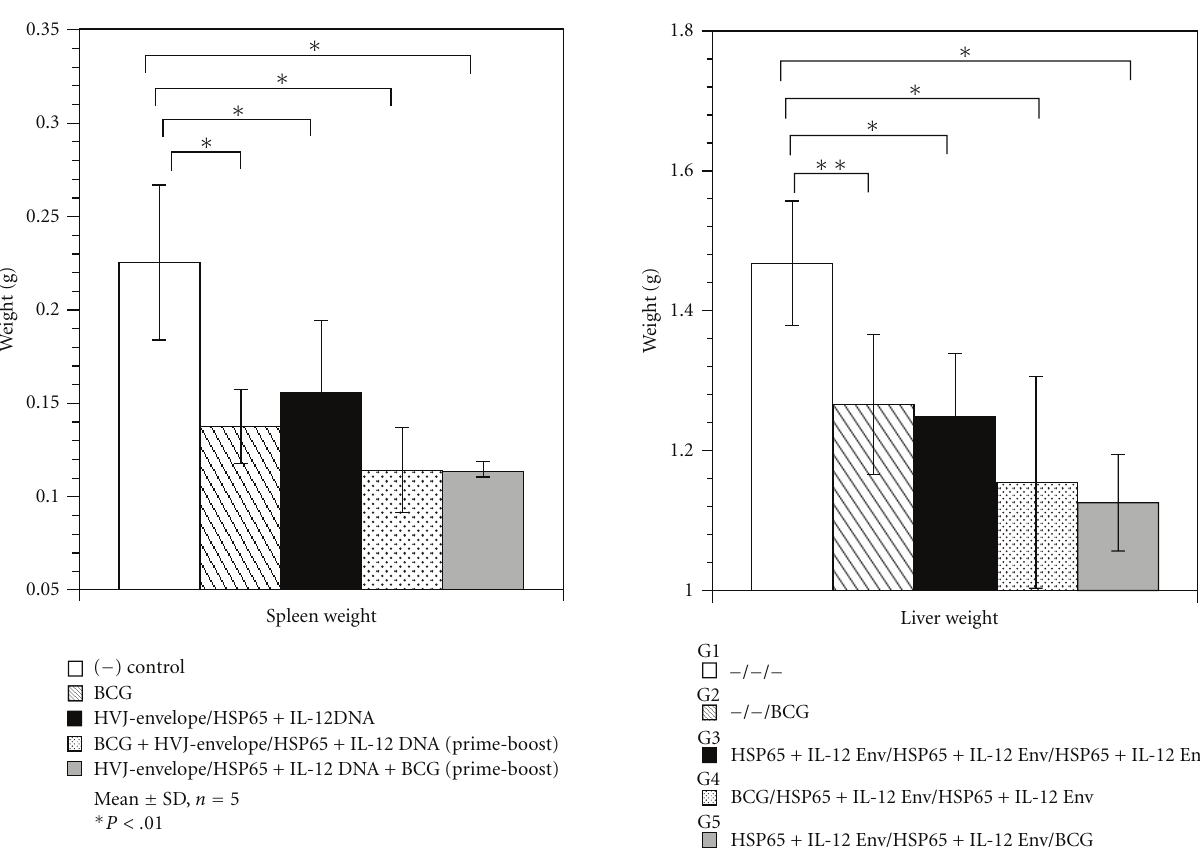
Figure 4: Tissue weight in mouse protection studies using the prime-boost method. Groups of mice vaccinated with HVJ-E DNA and/or BCG were challenged by intravenous injection with M. tuberculosis H37Rv. Five weeks after challenge, spleen weight was measured. Results are expressed as the mean ± S.D. in grams (g). The statistical significance of di ff erences between individual groups in the weight was determined by Dunnett test ( n = 5), ∗ P ≤ . 01; the statistical significance of di ff erences ( P < . 01) of the G1 (naive) group compared to the G2 group (BCG-alone group), G3 group (DNA/DNA/DNA), G4 group (BCG/DNA/DNA), or G5 group (DNA/DNA/BCG).